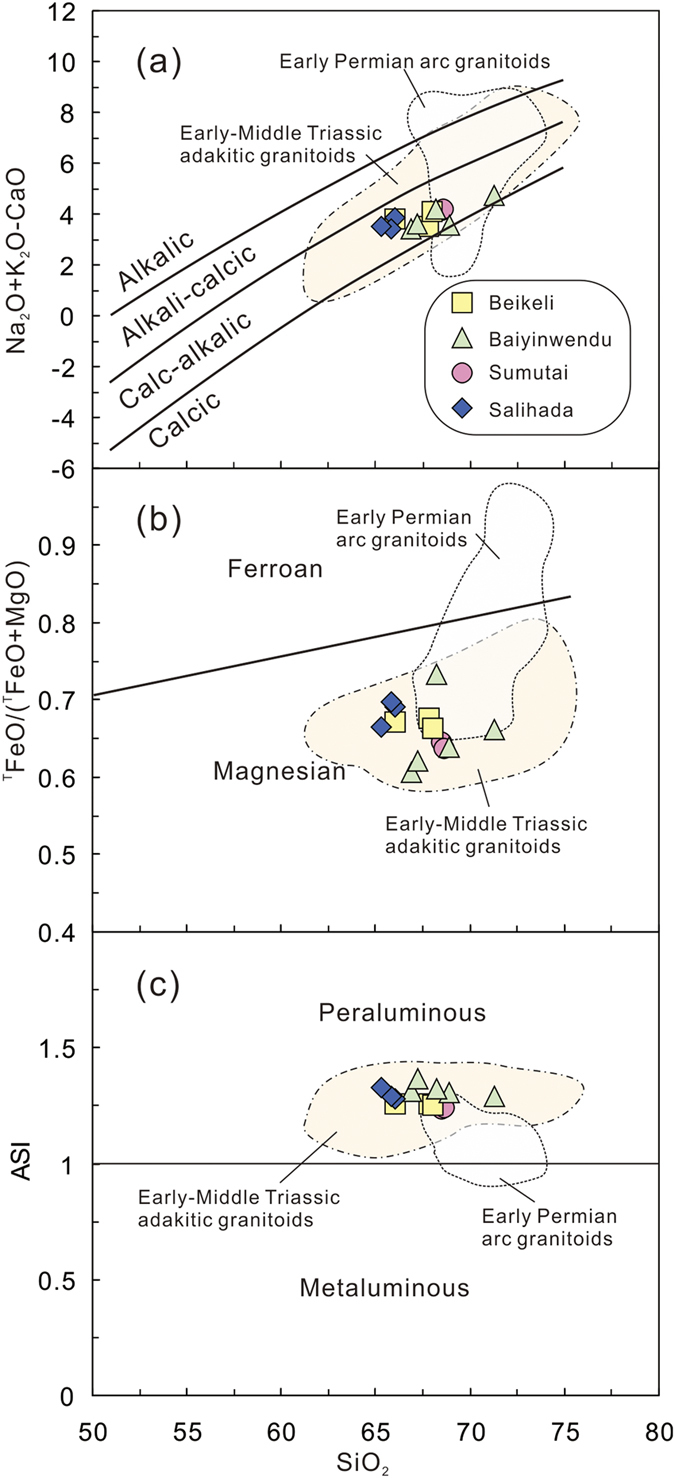
Selected major element diagrams for the Beikeli, Baiyinwendu, Sumutai and Salihada plutons.(a) Na2O + K2O - CaO vs. SiO2 diagram56, (b) TFeO/(TFeO + MgO) vs. SiO2 diagram56 and (c) ASI vs. SiO2 diagram56. TFeO = FeO + 0.9 Fe2O3, ASI = molecular Al/(Ca − 1.67P + Na + K). Data for the early Permian arc granitoids and Early-Middle Triassic adakitic granitoids are from refs 15,19 and 23.